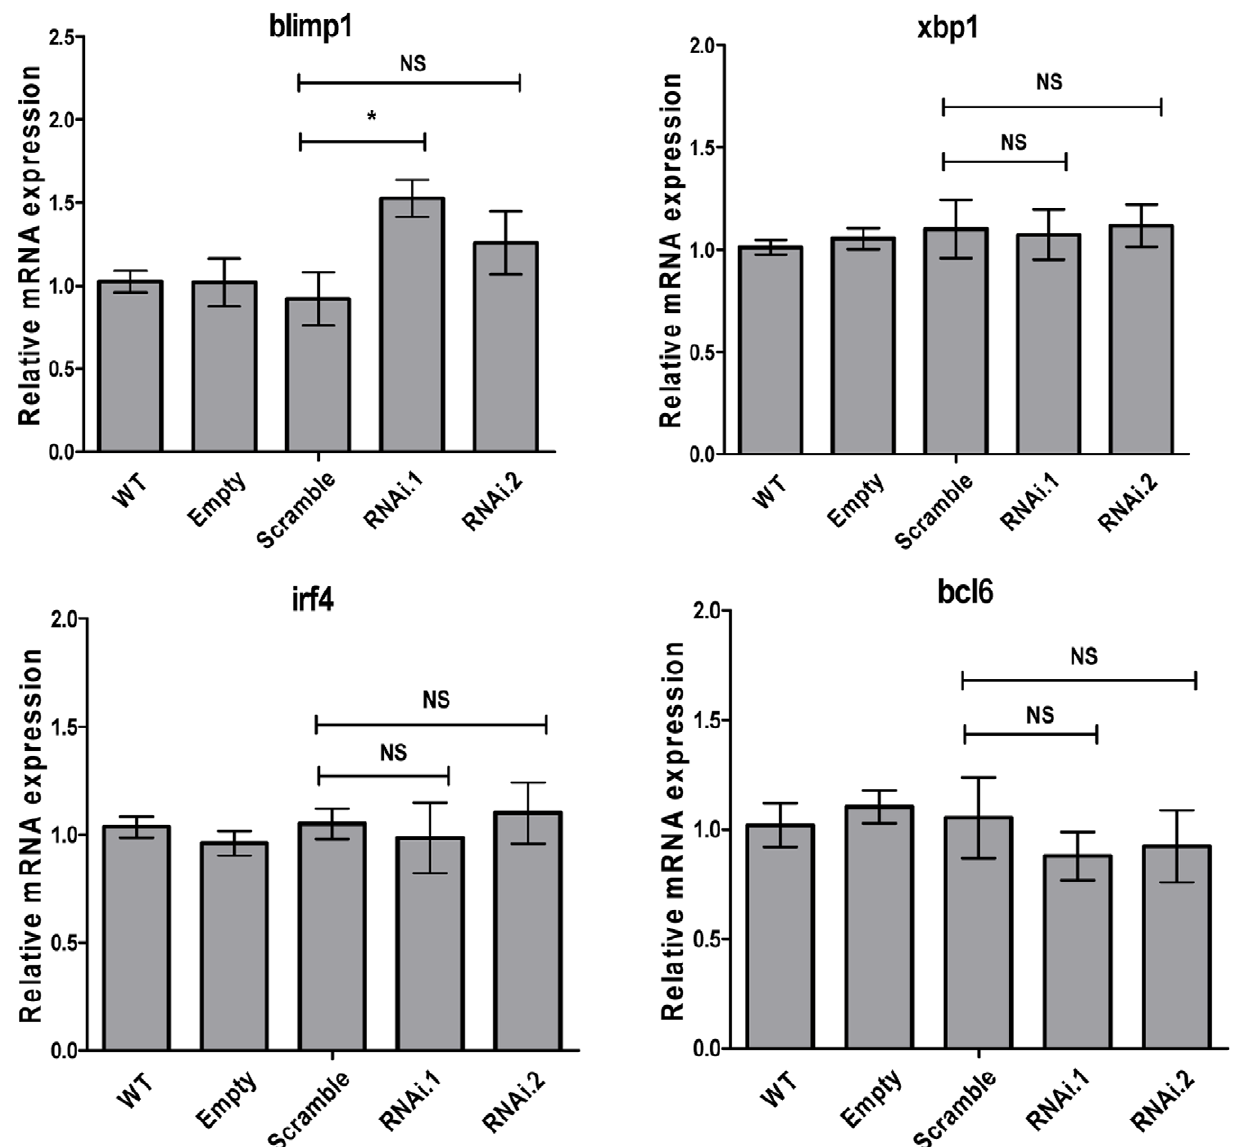
Figure 7. qRT-PCR analysis of plasmacytoid differentiation associated mRNAs in different BCL1 cell lines. qRT-PCR analysis of blimp1, xbp1, irf4 and bcl6 mRNA expression in pSicoR.zfp36l1.RNAi1 and pSicoR.zfp36l1.RNAi2 BCL1 cells compared to compared to wild-type, empty vector or pSicoR.scramble.RNAi infected cells. Cells were cultured in medium alone for 48h. Total RNA was extracted from 5 6 10 6 cells, 1 m g RNA was reverse transcribed and the resulting cDNA was used as template for qRT-PCR assay with mouse gene specific primers for blimp1, xbp1, irf4 and bcl6. The 2 – DD CT method of relative quantification was used to determine the fold change in mRNA expression compared to levels in wild-type cells. Mean 6 SD (n=3) are shown for three independent cell lines generated for each of the lentivirus infected cells. *=p , 0.05 as determined by